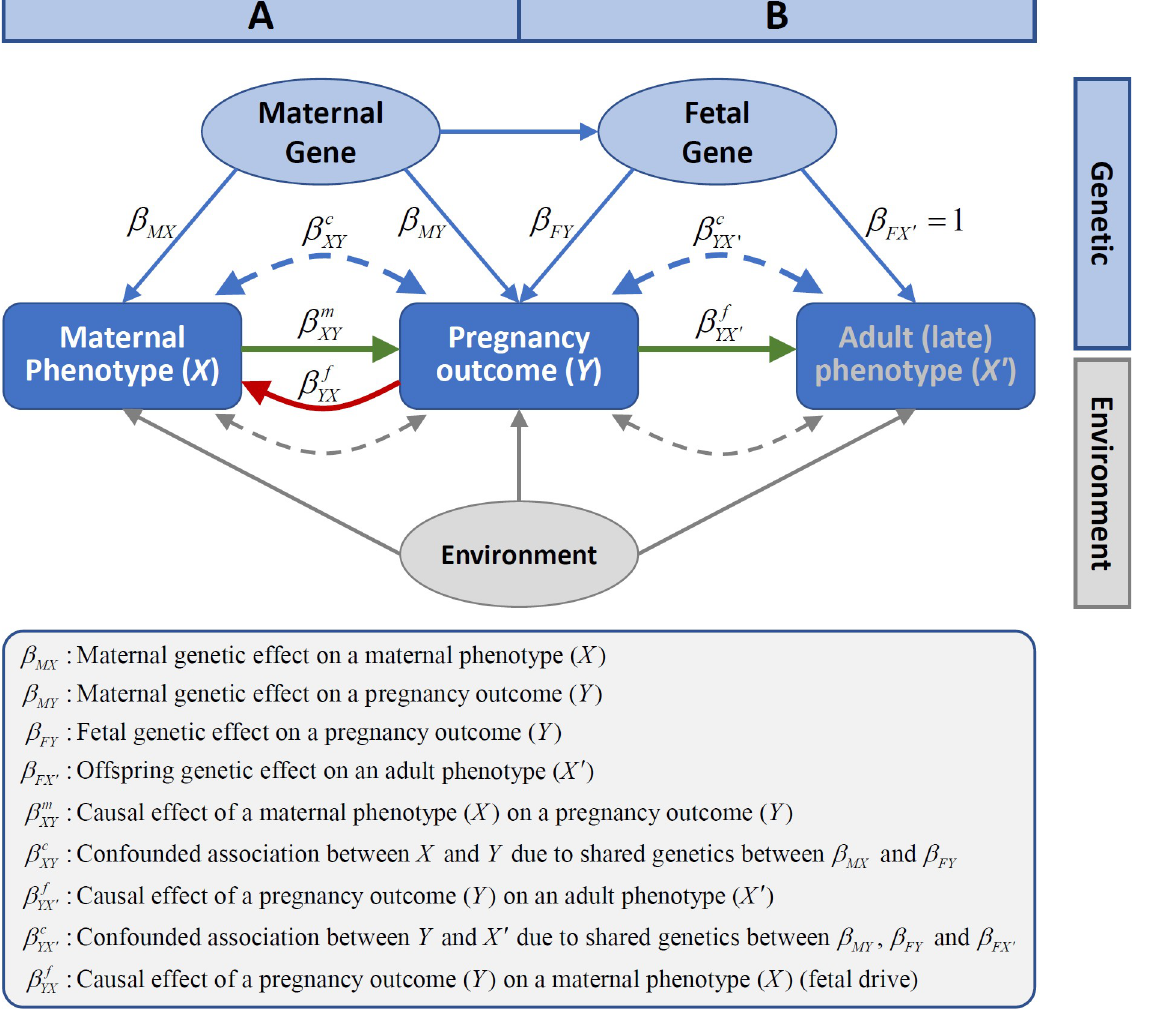
Fig 1. The different mechanisms underlying (A) the associations between maternal phenotypes and pregnancy outcomes and (B) the associations between pregnancy outcomes and late adult phenotypes in offspring. These mechanisms include 1) causal effects of maternal phenotypes on pregnancy outcomes ( b m ) and causal effects of pregnancy outcomes on adult phenotypes ( b f ) (green arrows), 2) genetically YX 0 XY ) because of genetic sharing between mothers and confounded associations between maternal phenotypes and pregnancy outcomes ( b c XY ) because of shared genetic infants and genetically confounded associations between birth outcomes and adult phenotypes in offspring ( b c YX 0 effects (blue dashed arrows), 3) confounding due to environmental effects (gray dashed arrows, which were not examined in this study), and 4) )—fetus causally influencing maternal phenotypes during pregnancy (red arrow). fetal drive ( b f YX